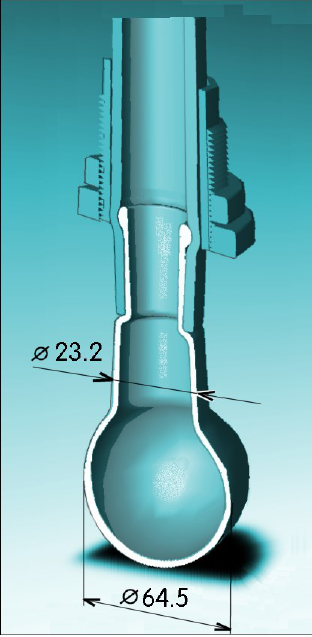
Fig. 17. The glass flask that served as the spherical capsule shell, shown here in section by meridian plane. It was held on top by the flask inlet, making possible volume changes without stressing the shell material (glass). Trade name of the glass material is SIMAX . Its mechanical and thermal properties are listed in Tab. IV.